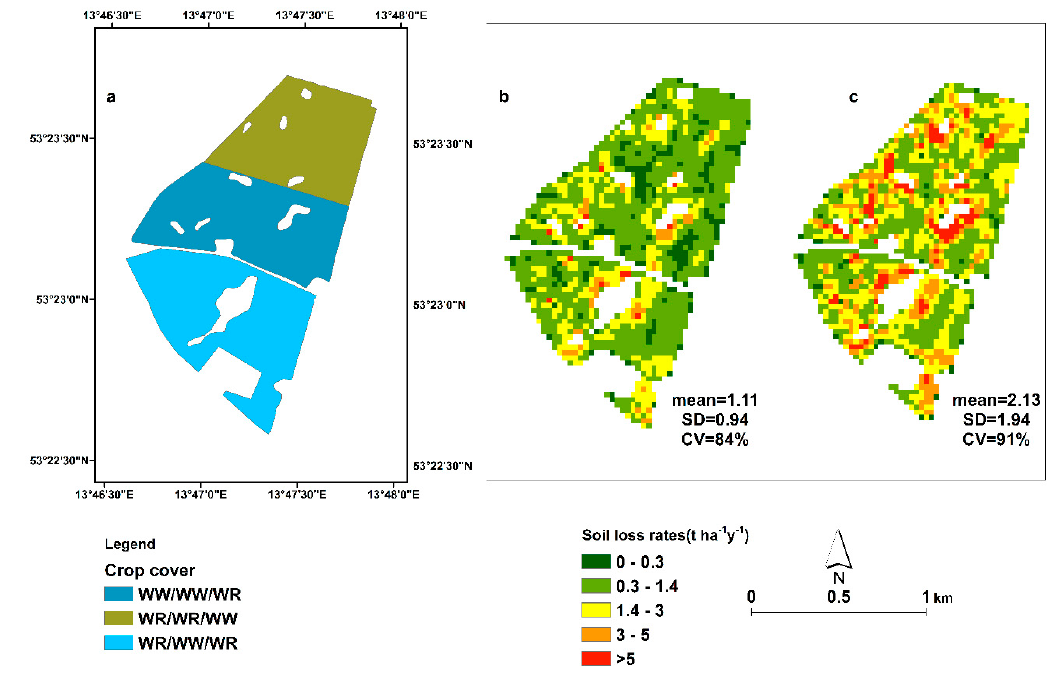
Figure A4. Three years average potential soil erosion rate in a catchment around Holzendorf experimental station: ( a ) land cover type from 2014 to 2016 cropping year identified through the IACS data; ( b ) and ( c ) erosion predicted using C lit (SL clit ) and using C ndvi (SL cndvi ), respectively. Compared to the long-term experimental results, which ranged from 0.5 to 5 t ha − 1 y − 1 , the values predicted using the USLE can fairly be taken as representative.